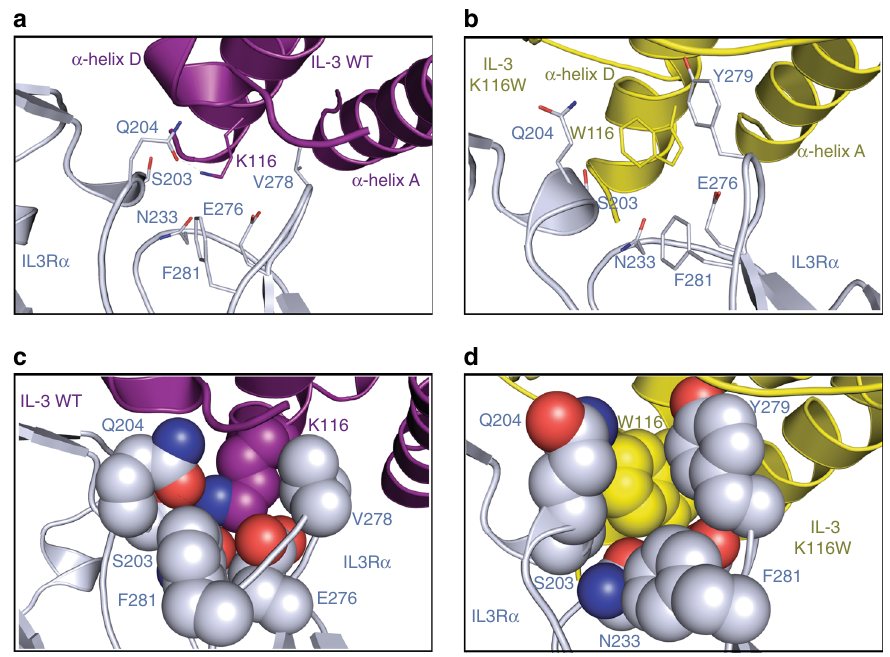
Fig. 4 Structure of IL3R α bound to IL-3 K116W. a Close-up view of the environment around IL-3 K116 in site 1a of the wild-type IL-3 binary complex. Colour scheme as described for Fig. 1b – d. b Close-up view of the environment around W116 in site 1a of the IL-3 K116W binary complex. IL3R α coloured blue-grey and IL-3 K116W coloured yellow. c Residues around IL-3 K116 in the wild-type IL-3 binary complex displayed as spheres to demonstrate the volume they occupy and the residue packing at this site. d As for c , but for the IL-3 K116W binary